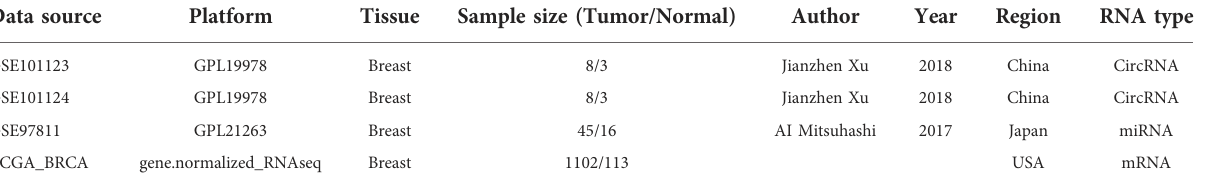
TABLE 1 Basic information from the GEO microarray and TCGA RNA-seq datasets.